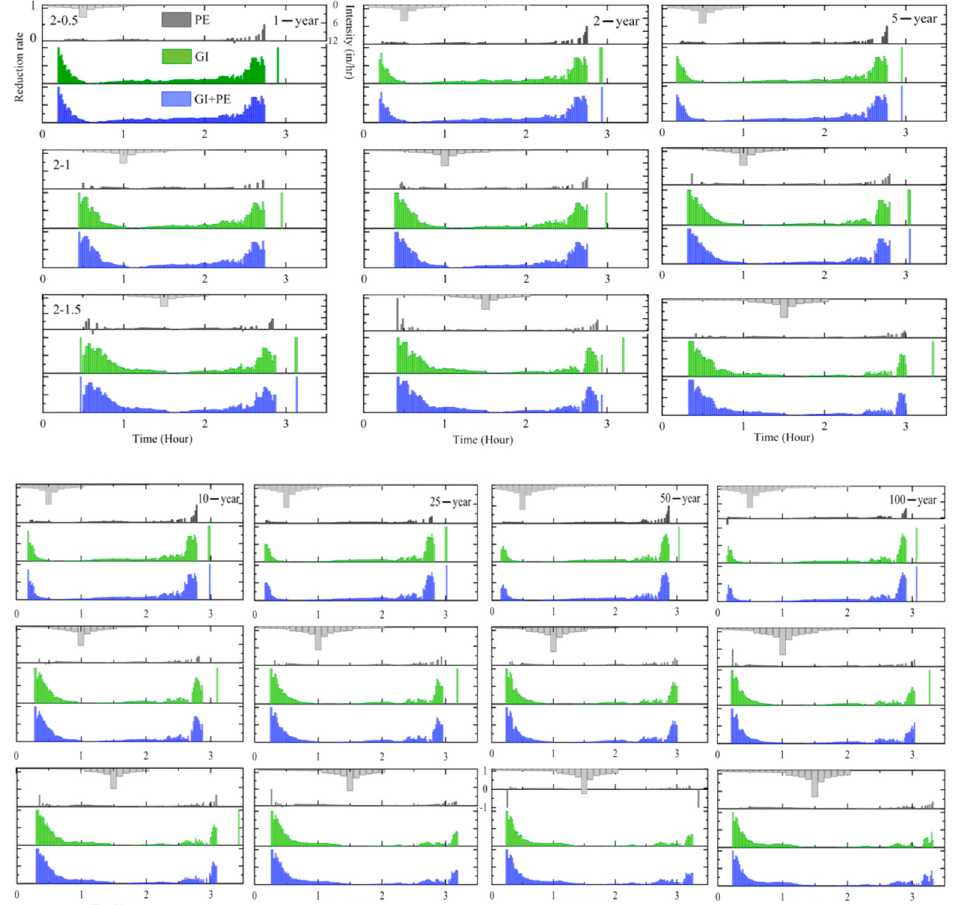
Figure 7. The fraction of road inundation reduction in different rainfall patterns of short-term events. The dark grey area is the scheme of pipe enlargement (PE), the green area is the GI scheme, and the blue area is GI + PE.